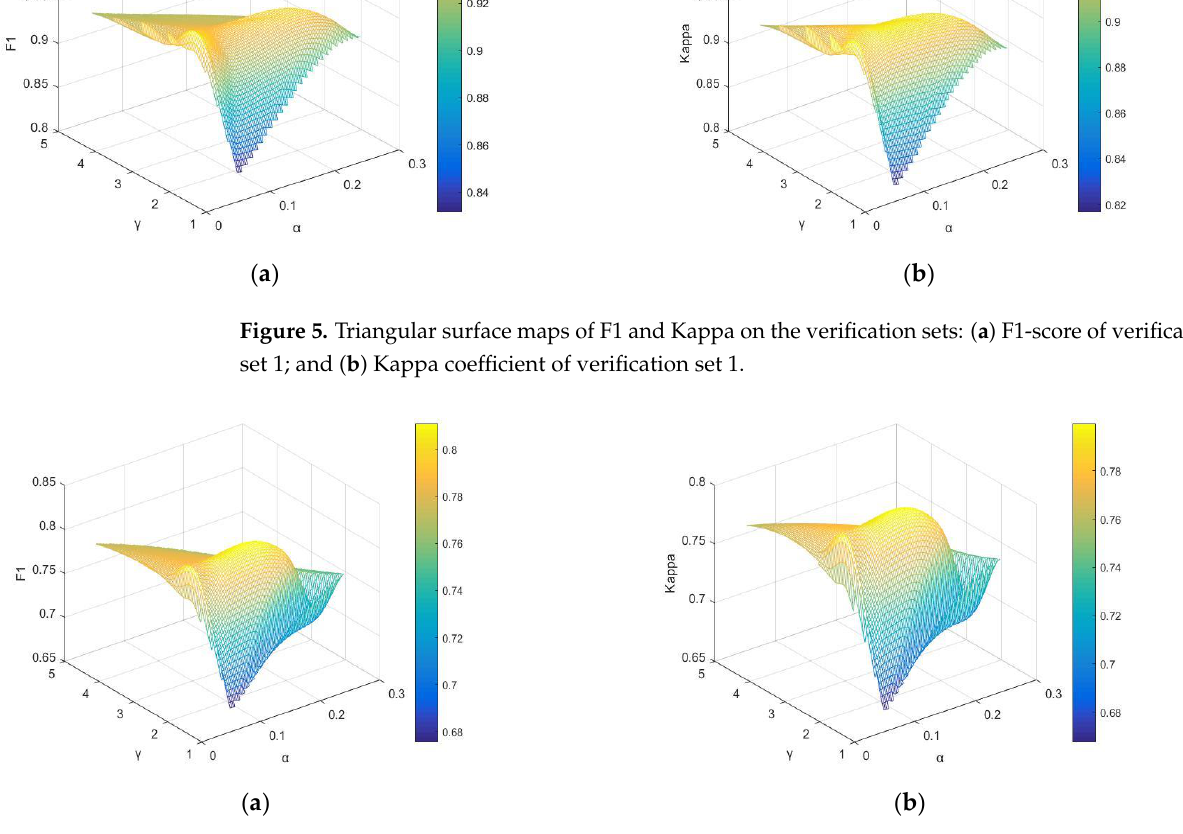
Figure 6. Triangular surface maps of F1 and Kappa on the verification sets: ( a ) F1-score of verification set 2; and ( b ) Kappa coefficient of verification set 2.